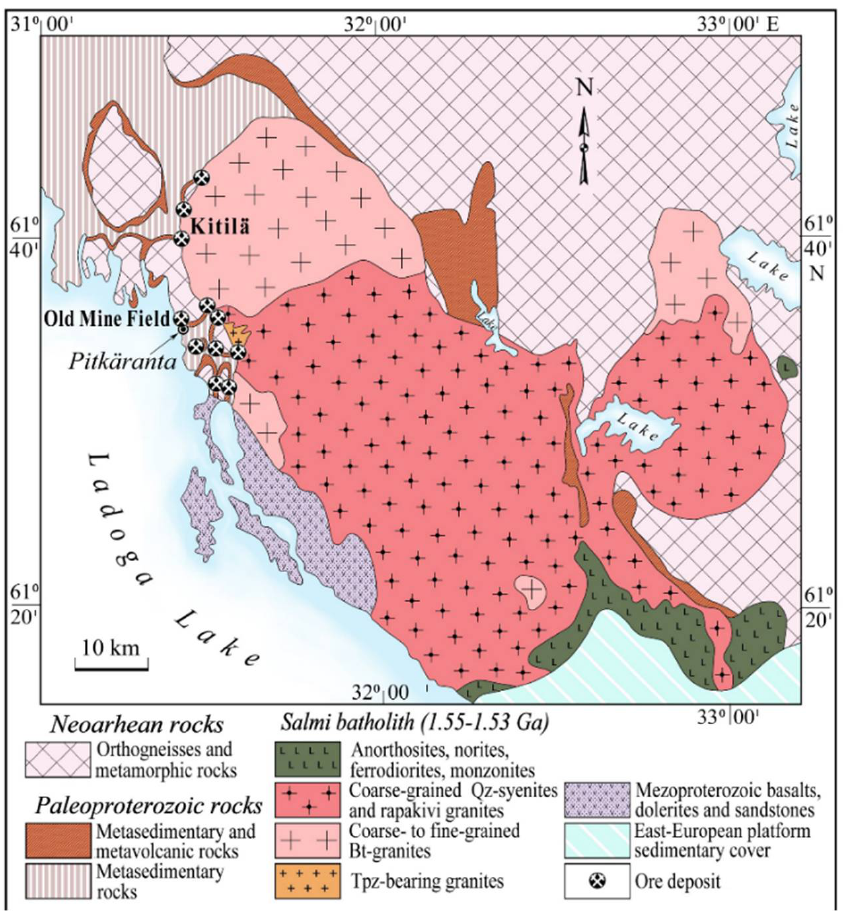
Figure 4. Geologic map of the Pitkäranta mining district, South Karelia, showing locations of skarn deposits. Modified from Amelin et al. [55] and Larin [58]. Bt—biotite; Qz—quartz; Tpz—topaz.